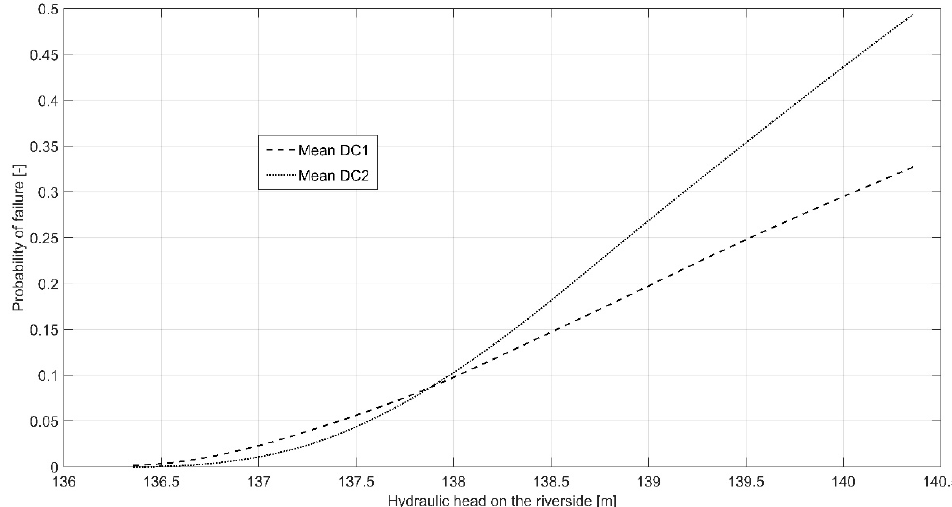
Figure 13. Mean curves for PDC1 and PDC2.